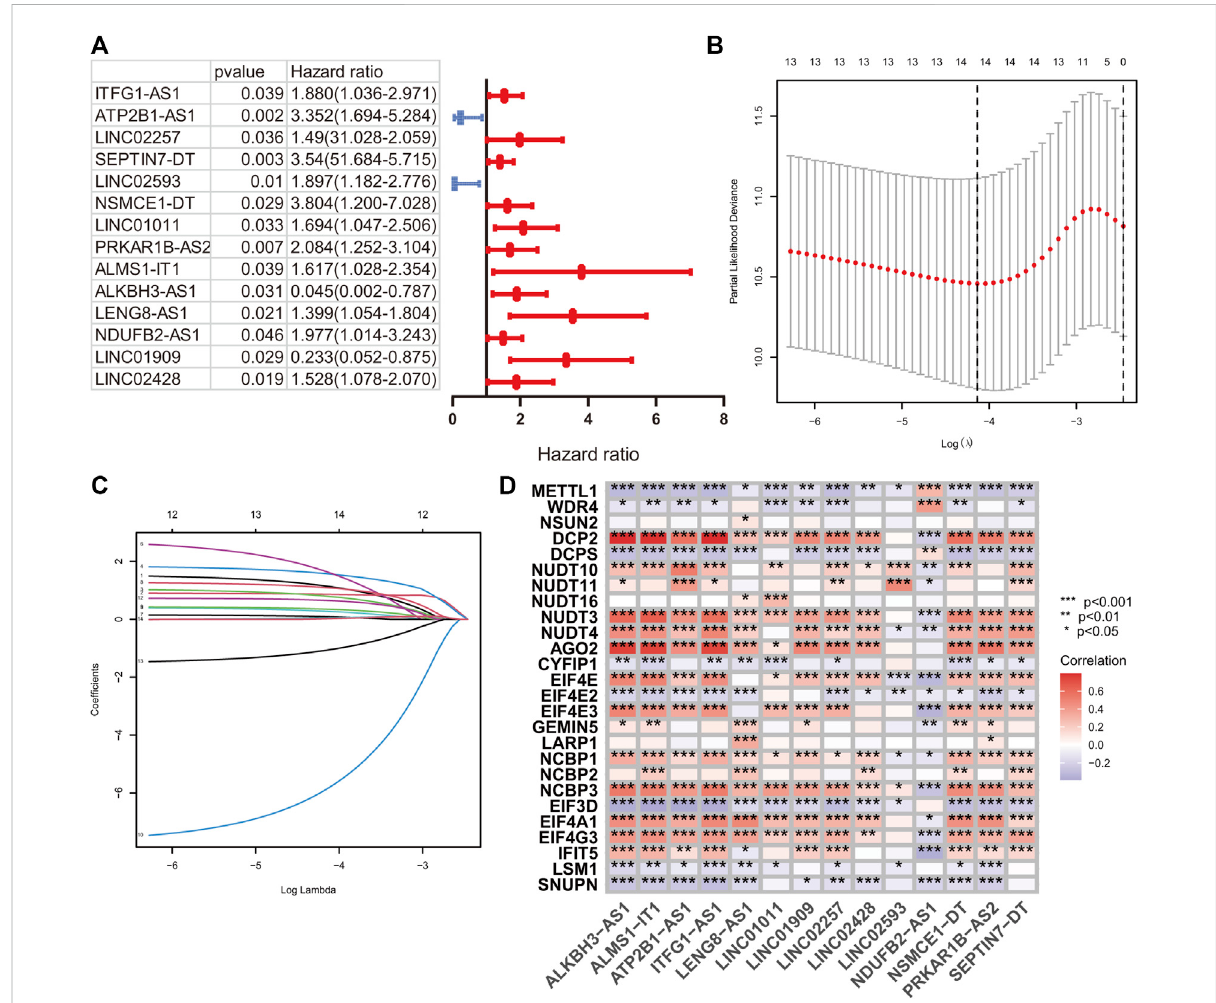
FIGURE 2 m7G-related signature construction. (A) The univariate hazard analysis of prognostic m7G-related lncRNAs in the development set. (B and C) LASSO analysis on 14 prognostic m7G-related lncRNAs in the development set. (D) The Pearson correlation analysis of m7G-related regulators and 14 prognostic m7G-related